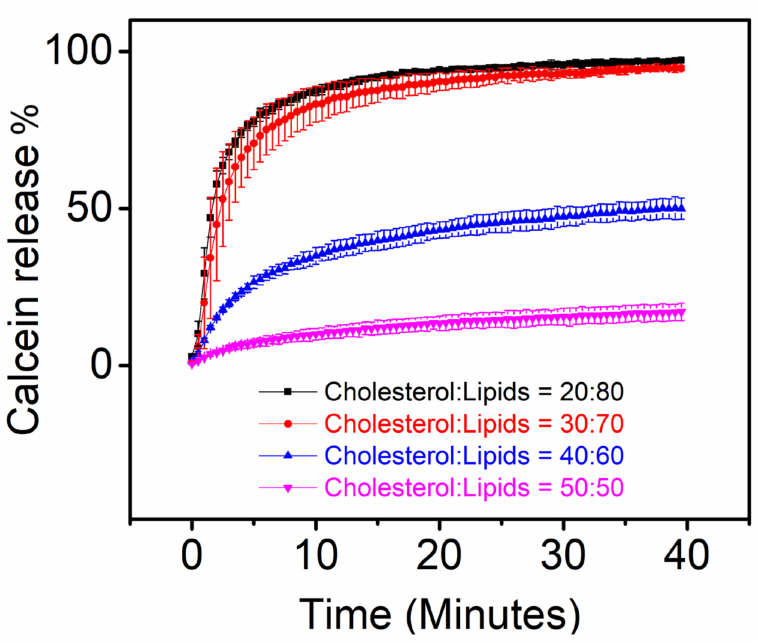
Figure 3. Cholesterol concentration dependent permeabilization of liposomes induced by the mem- brane binding of His-tagged GB1-fused Vpr. The molar ratio of cholesterol to lipids (DOPC:DOPG = 1:1) in liposomes was increased from 20% to 50%. The reported values are the averages of the triplicate experiments and the standard deviation of each data point is represented as the error